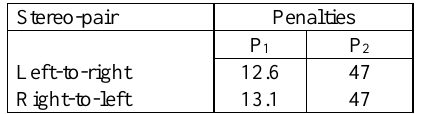
Table 3. Penalty values for the stereo-pair of Herz-Jesu-K7 estimated by the suggested method.